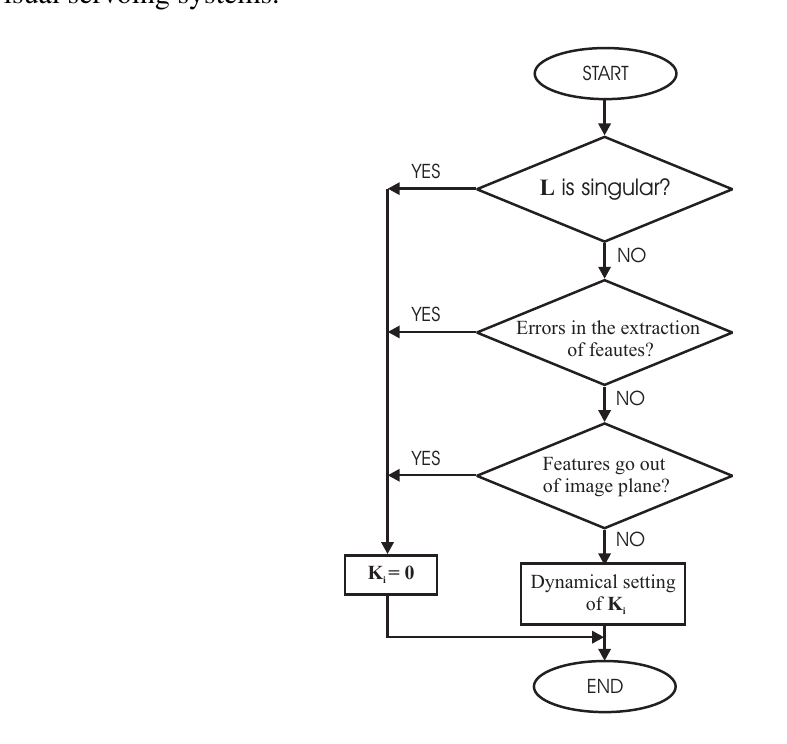
Figure 3. Flow chart of the routine used to detect the potential problems of image-based visual servoing